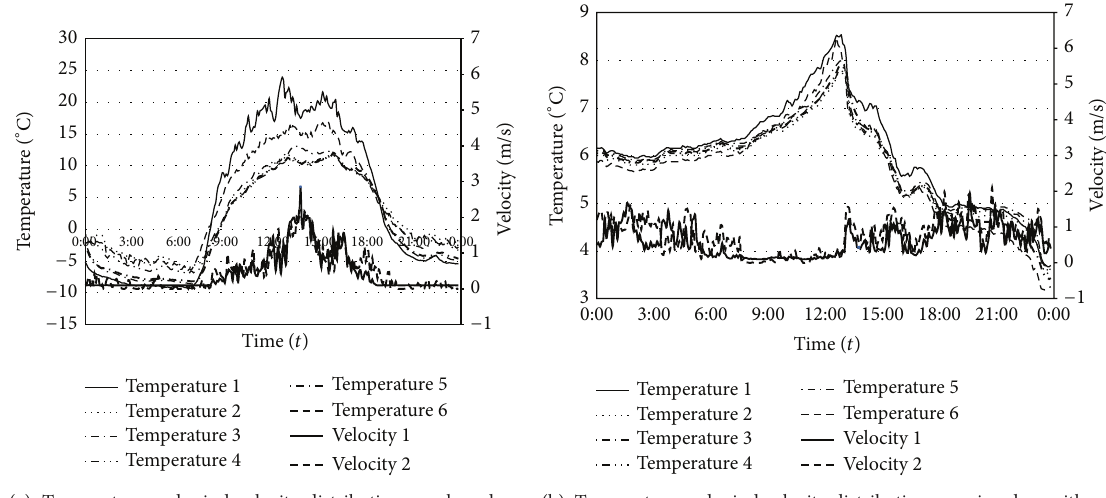
Figure 13: Temperature and wind velocity distribution on clear days and rainy